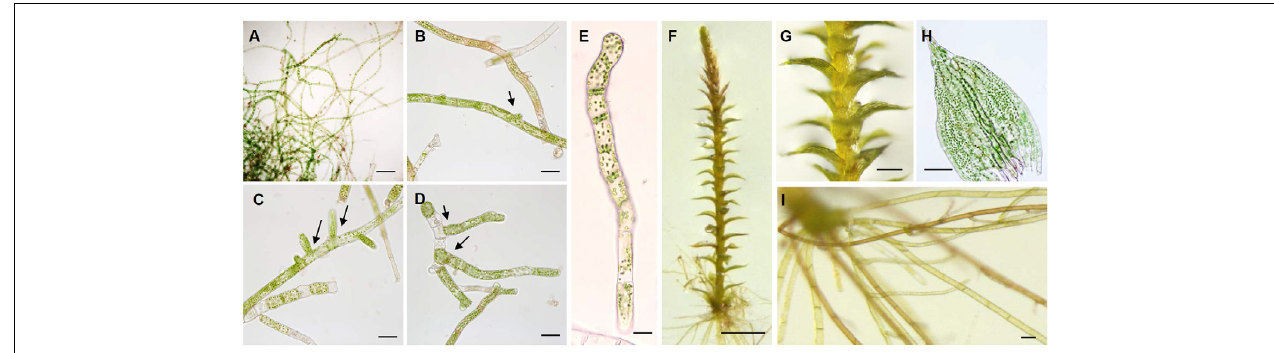
FIGURE 1 | Characterization of axenic cultivation of KMR5045. Morphological analysis of cells in the protonema stage. (A) Filamentous protonema cells developed after 5 days of cultivation. (B–D) Side branching and filament elongation are indicated by the arrow. (E) Chloronema cells composed of rectangular cells with chloroplasts and transverse cross walls. Gametophore stages of KMR5045. (F) Gametophore cultivated for 1 month on solid Knop medium. (G) Growth of new shoots. (H) Leaf structure of KMR5045 gametophore. (I) Rhizoids with brown-pigmented walls. Scale bars (A,G) 200 µ m; (B–D,H,I) 50 µ m; (E) 20 µ m; (F) 1 mm.